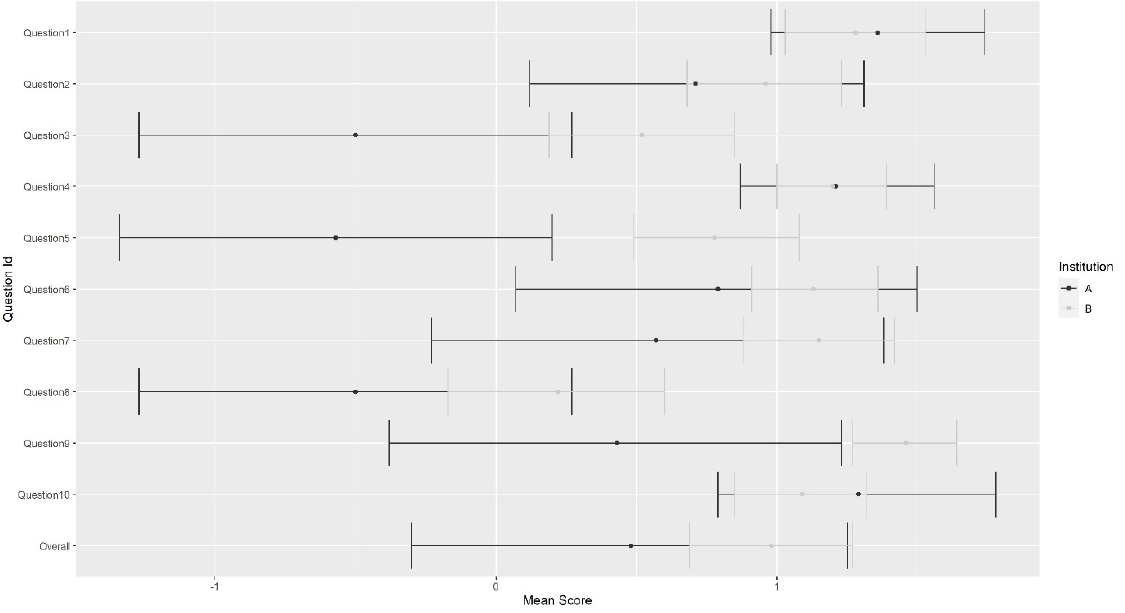
Figure 1. Mean score and confidence intervals by question and school.